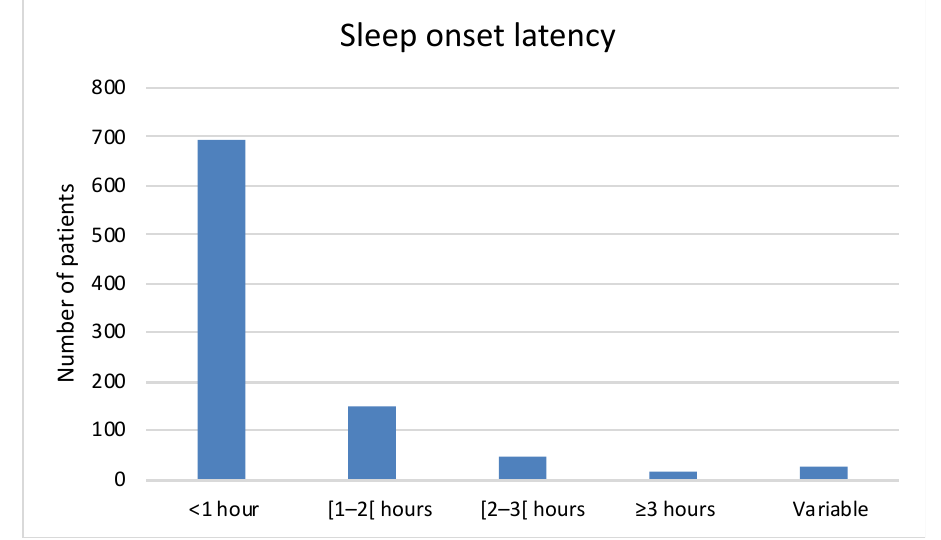
Figure 1. Sleep onset latency. Table 2. Cause of nocturnal awakening. Data were missing for 9 of the 960 patients.